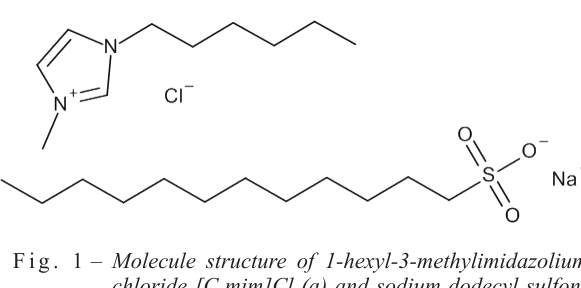
Fig. 1 – Molecule structure of 1-hexyl-3-methylimidazolium chloride